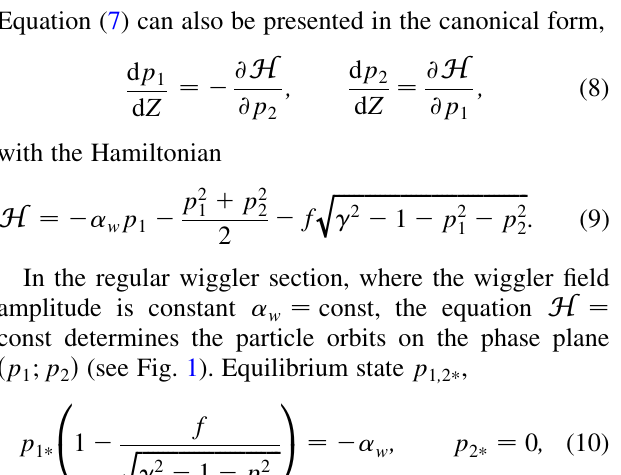
FIG. 1. The electron orbits on the phase plane ð p different strengths of guide magnetic field: (a) f > f